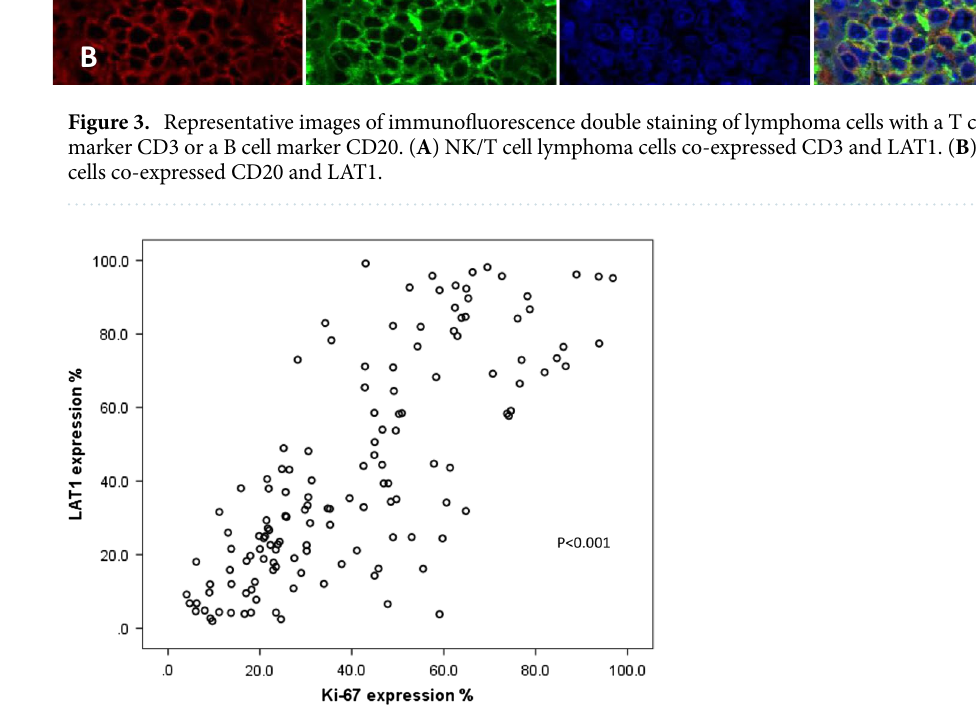
Figure 4. Correlation between LAT1 and Ki-67 expression. LAT1 expression level in NHL is strongly associated with Ki-67 expression which is cell proliferation marker (by the Spearman’s rank test r = 0.767, P <